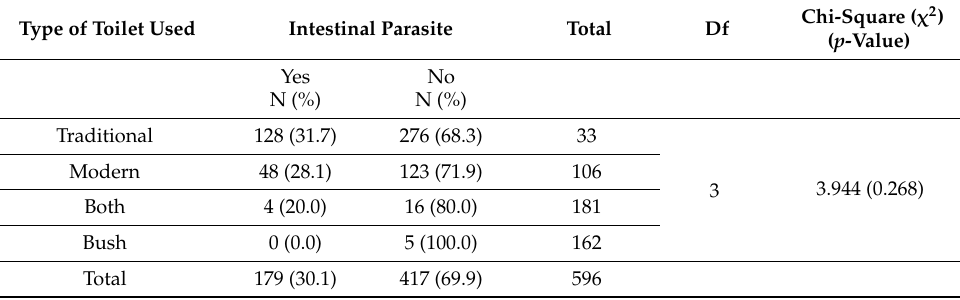
Table 5. Prevalence of intestinal parasites by type of toilet